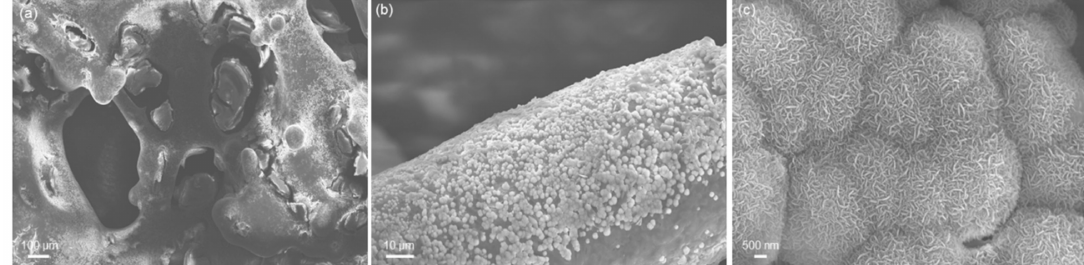
Figure 11. SEM micrographs of 5Cu-MBG-SCNA scaffold after 15 days of immersion in SBF: ( a ) overview of the macroporous structure (magnification 200 × ); ( b ) newly formed globular agglomerates onthesurfaceofatrabecula(magnification3000 × ); and( c )nanocrystallinenatureofthishydroxyapatite-like phase (magnification 30,000 × ) characterized by needle-shaped crystals organized according to a typical cauliflower